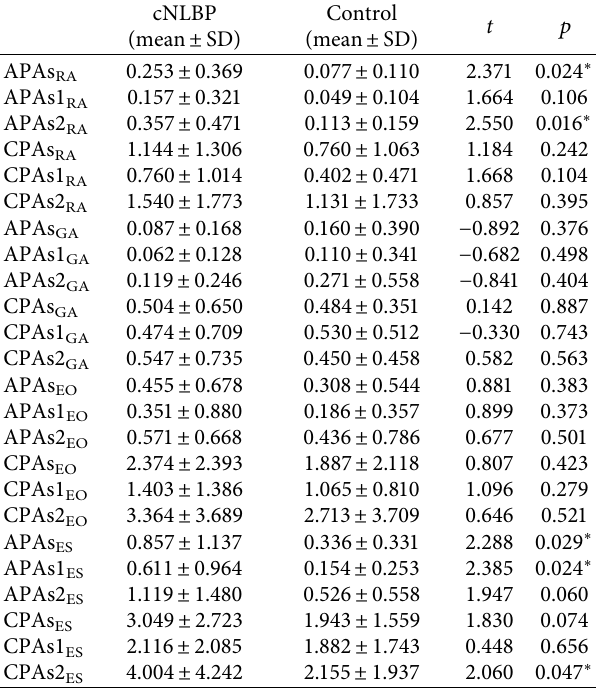
Table 2: The muscle iEMGs between the cNLBP and control groups in the internal perturbation task